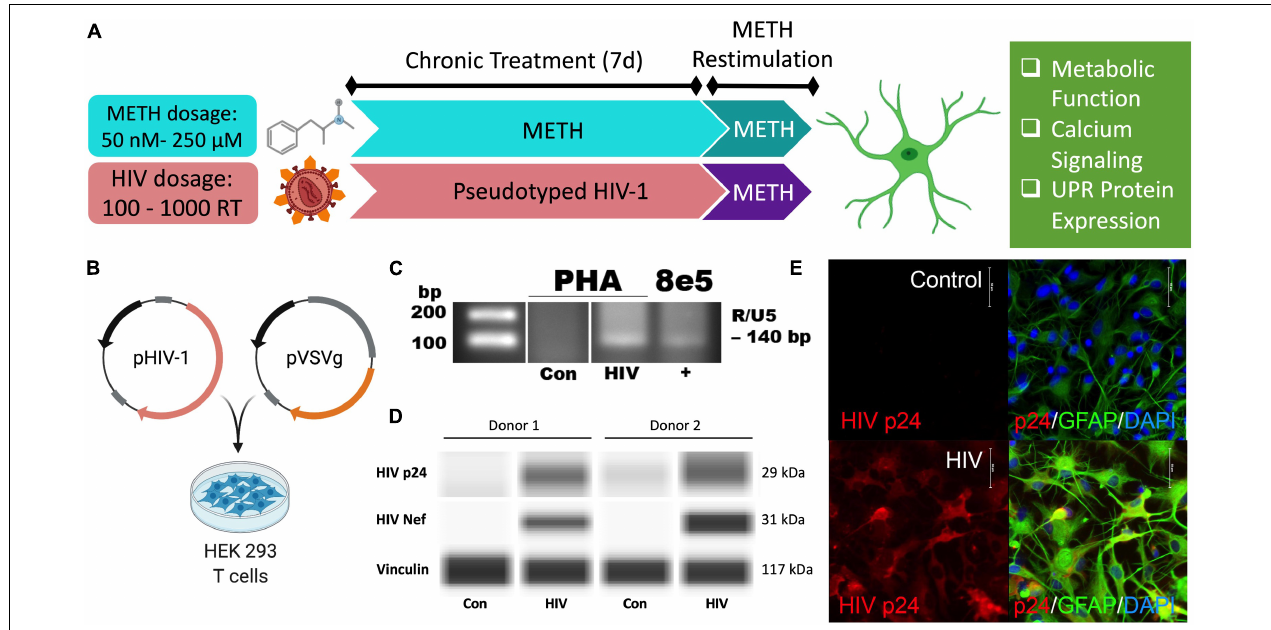
FIGURE 1 | Pseudotyped HIV-1 infection in astrocytes is characterized by HIV-1 DNA integration and productive protein expression. (A) Schematic of the proposed experimental design to assess the effects of METH exposure and HIV-1 infection on astrocyte ER-mitochondrial homeostasis. (B) Pseudotyped HIV-1 was constructed by co-transfecting an HIV-1 plasmid (pHIV-1) with vesicular stomatitis virus glycoprotein plasmid (pVSVg) in HEK 293 T cells. (C–E) Primary human astrocyte (PHA) cultures were infected with (C,D) 500 RT pseudotyped HIV-1 for 5 days or (E) 1000 RT pseudotyped HIV-1 for 7 days followed by (C) HIV-1 DNA integration assay or (D) Simple Wes to detect expression of HIV-1 proteins p24 or Nef. Vinculin was used as an internal control. (E) Immunocytochemistry staining of HIV-1 protein p24 (red), astrocyte marker glial fibrillary acidic protein (GFAP, green) with nuclear DNA labeled with DAPI (blue). Experimental illustrations were made with